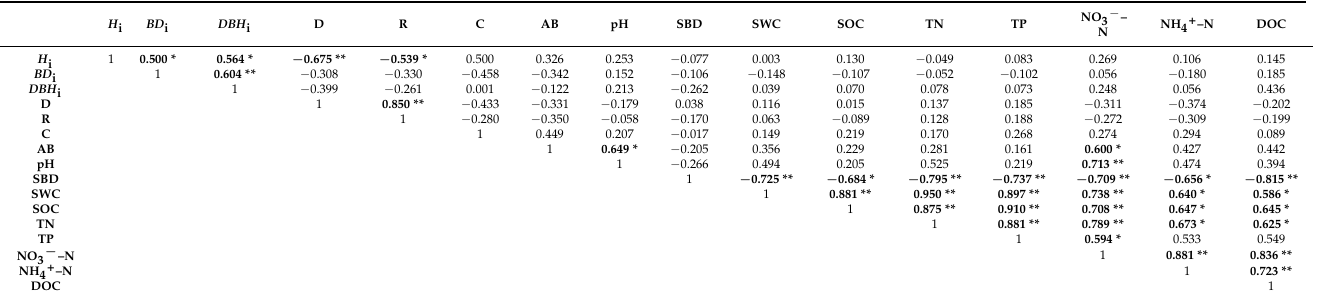
Table 4. Pearson correlation coefficients for relationships between plant performances and soil properties in the Mongolian pine plantation after sewage sludge